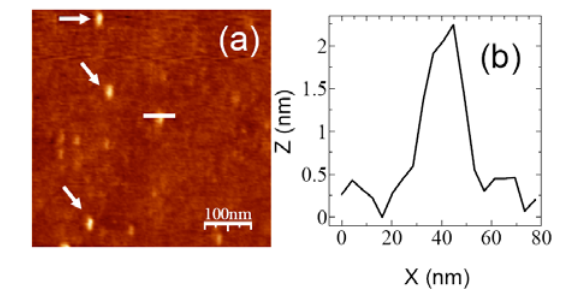
FIGURE 17. (a) AFM images of 2.4-nm Pd NPs onto a mica substrate; (b) height profile along the indicated line. (Courtesy of I.